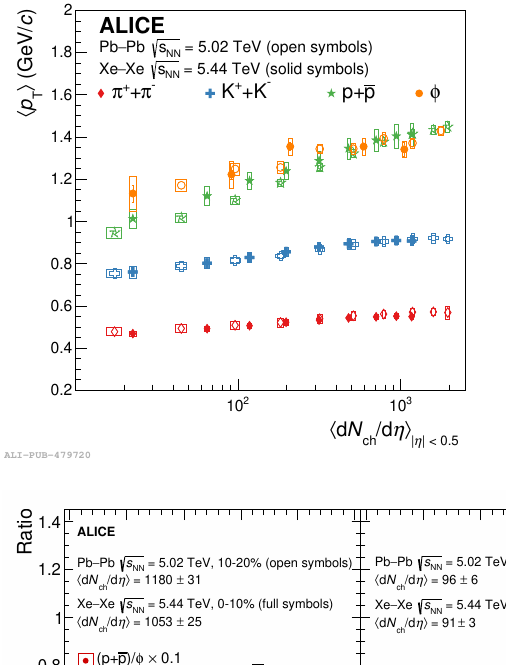
Figure 3. Left: p /φ and p /π as a function of the transverse momentum in 0– 10% central Xe–Xe colli- sions at √ s NN = 5 . 44 TeV [3] compared to 10–20% central Pb–Pb collisions at √ s NN = 5 . 02 TeV [7, 8] to match the charged particle multiplicity in the two sys- tems. The same is shown in the right panel for periph- eral